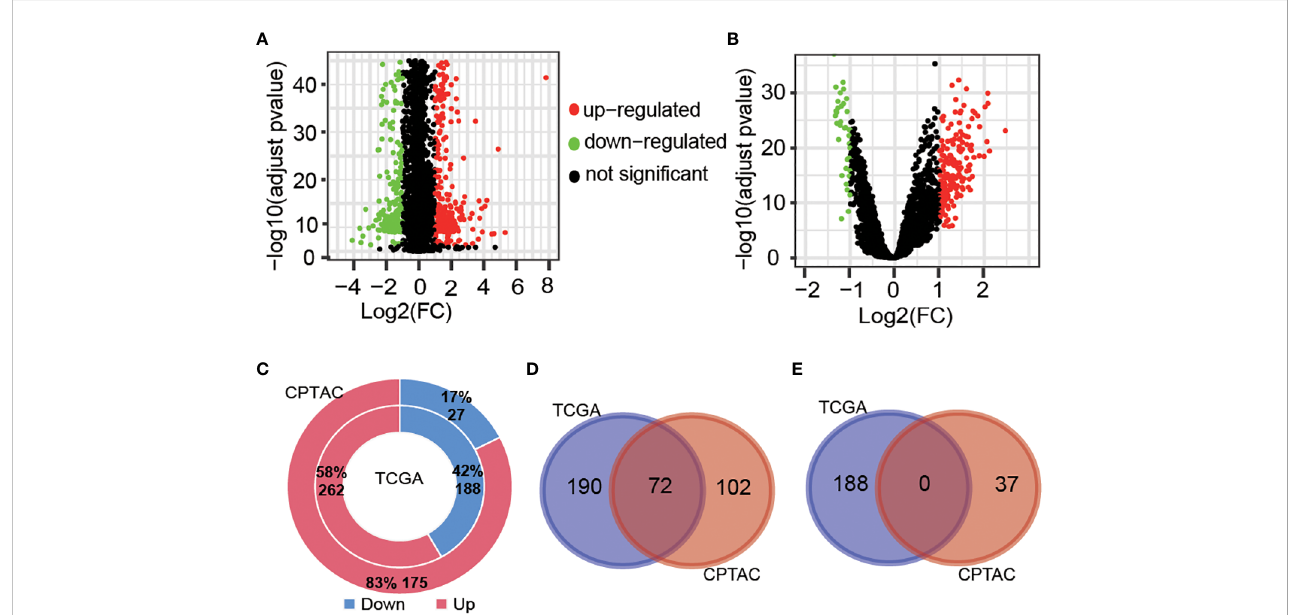
FIGURE 2 Different expressed gene analysis between tumor and normal samples. Volcanic map showing the difference of gene levels between tumor and normal samples in the TCGA cohort (A) and CPTAC cohort (B) . Genes with |Log2(FC)| >1 and adjust pvalue<0.01 were de fi ned as different expressed genes. (C) , Proportion and number of signi fi cantly up-regulated and down-regulated genes obtained from two cohort samples. Venn diagrams of up-regulated genes (D) and down-regulated genes (E) in TCGA and CPTAC